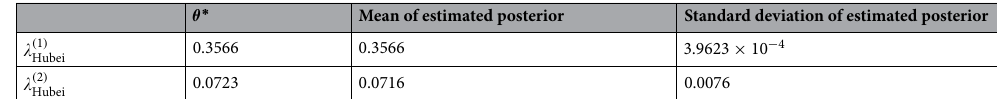
Table 7. Estimated transmission rates in Hubei. θ ∗ is inferred using (4.4) with µ = 10 2.3 , at which the validation errors are minimized as shown in Fig. 12 and Supplementary Fig. S5. The posterior distribution is estimated by 5 × 10 5 MCMC